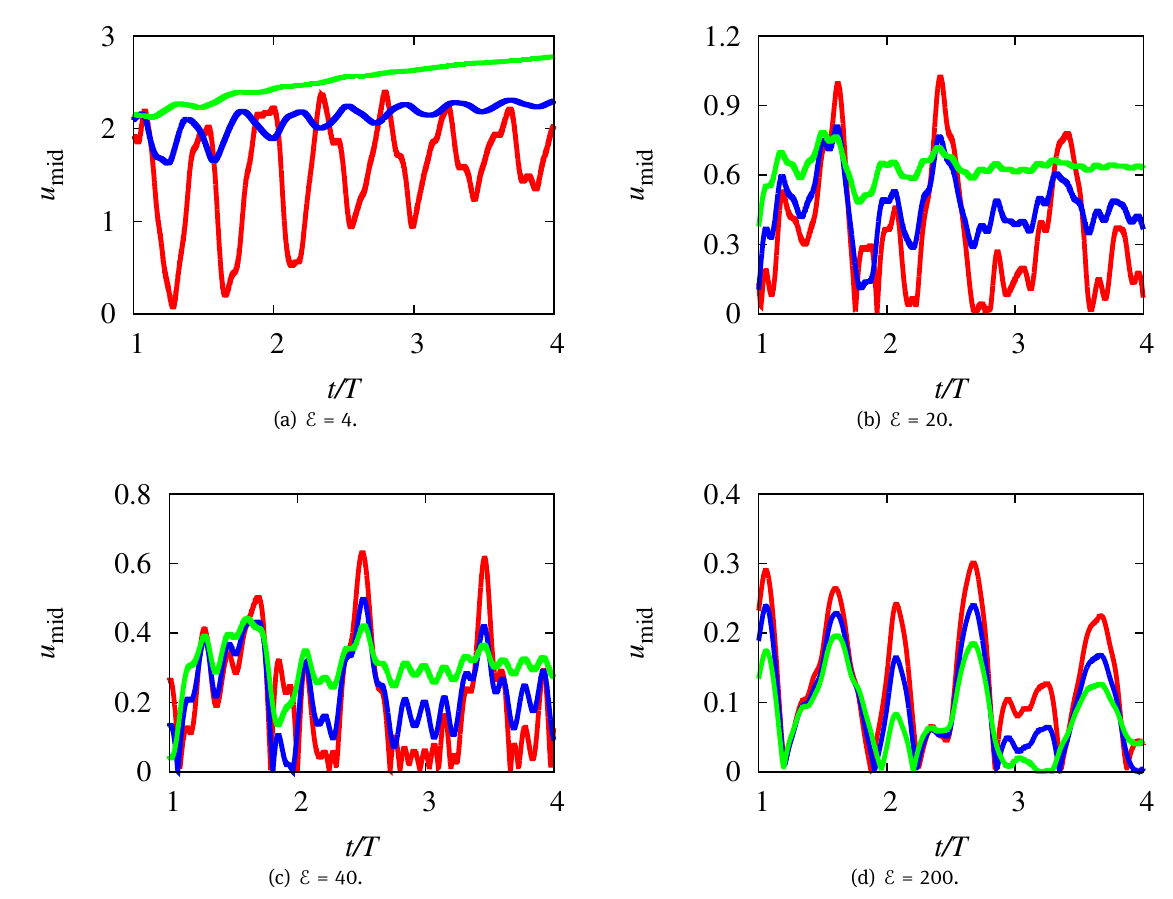
Figure 3: Time history of the displacement for different values of E at R = 15 (green curve), R = 50 (blue curve) and R = 100 (red